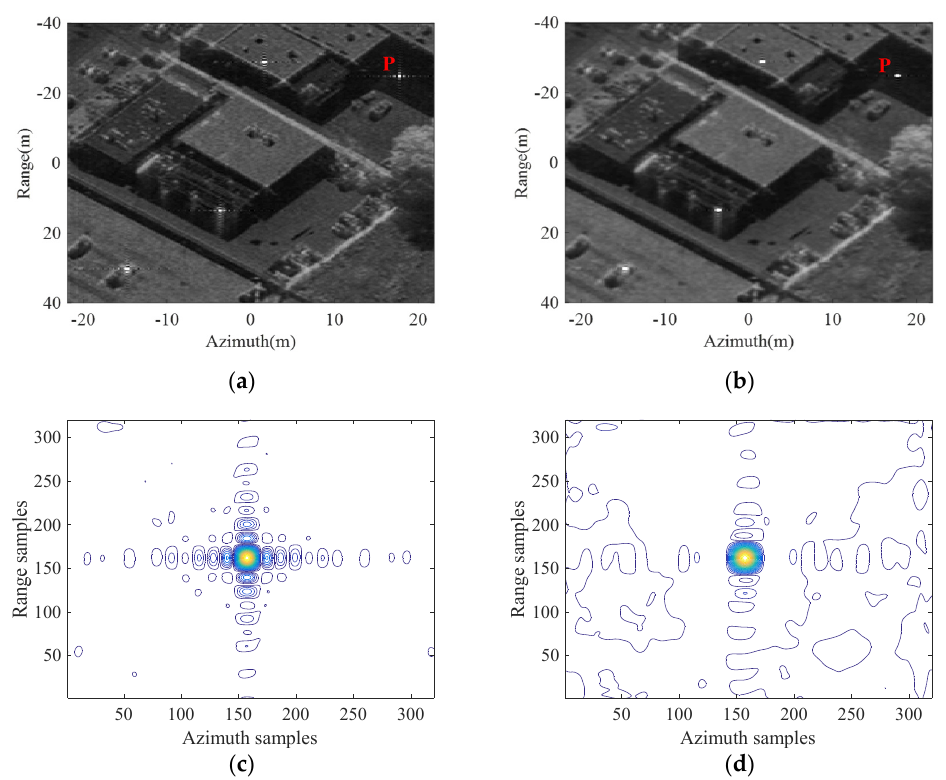
Figure 12. Distributed target simulation results. ( a ) The imaging result in the conventional starring spotlight mode. ( b ) The imaging result in the proposed mode. ( c ) Contour plots of P in the starring spotlight mode. ( d ) Contour plots of P in the proposed mode.